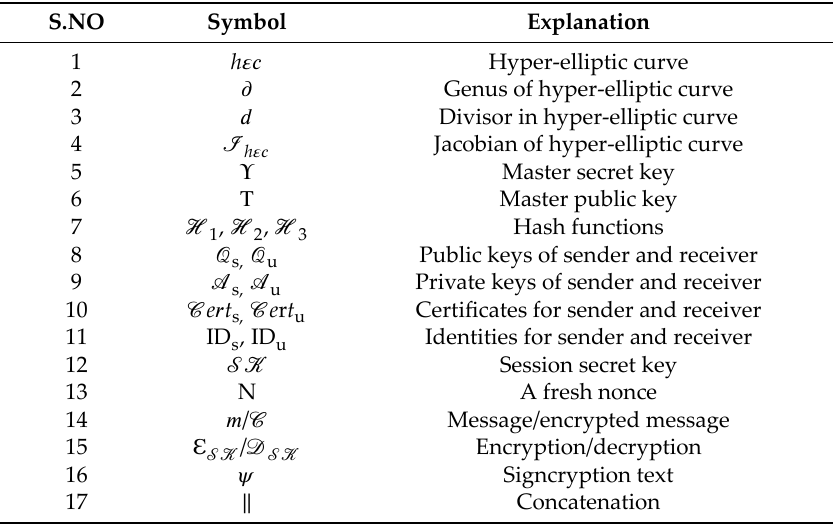
Table 1. Notations used in proposed